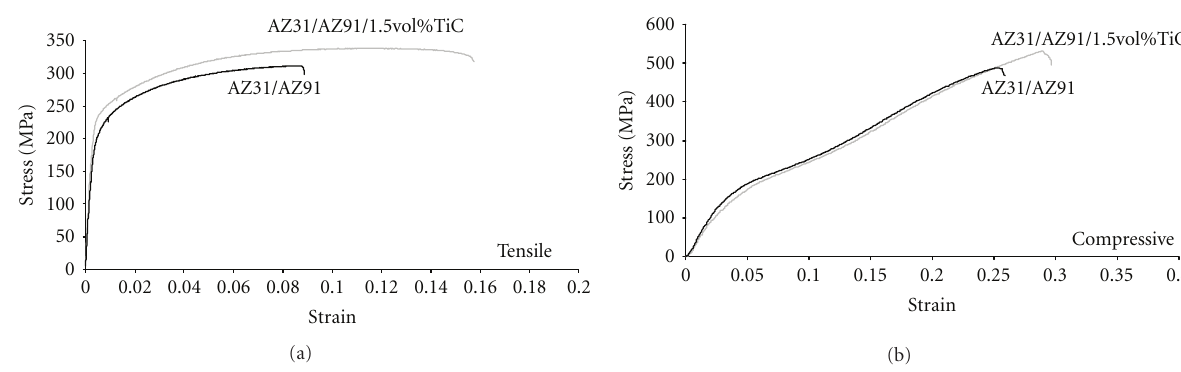
Figure 4: Representative: (a) tensile and (b) compressive stress-strain curves of monolithic AZ31/AZ91 and AZ31/AZ91/TiC nanocomposite.